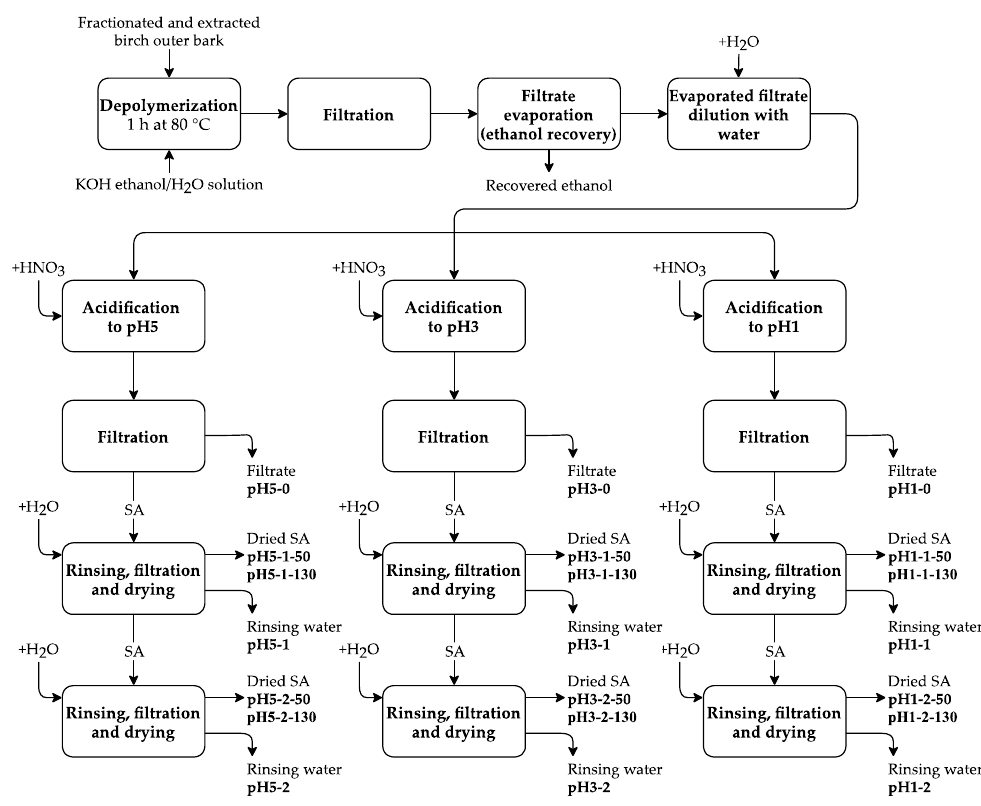
Figure 2. Experimental scheme for obtaining the SA samples.